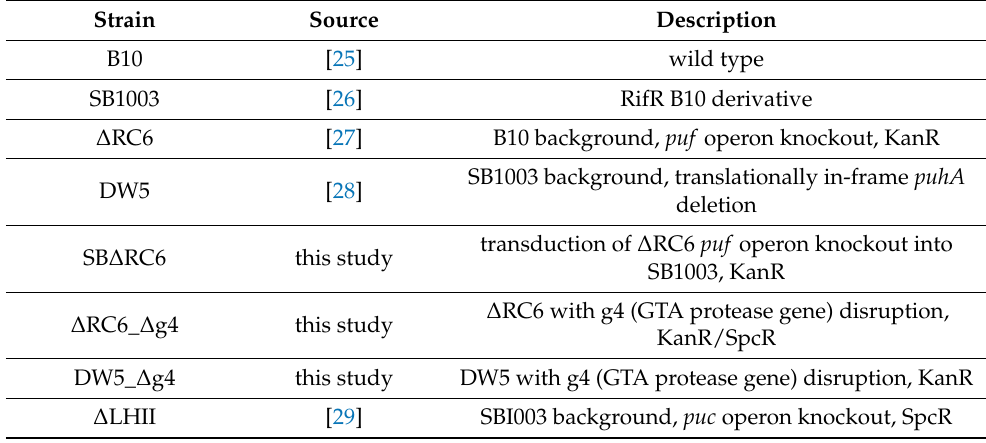
Table 1. List of R. capsulatus